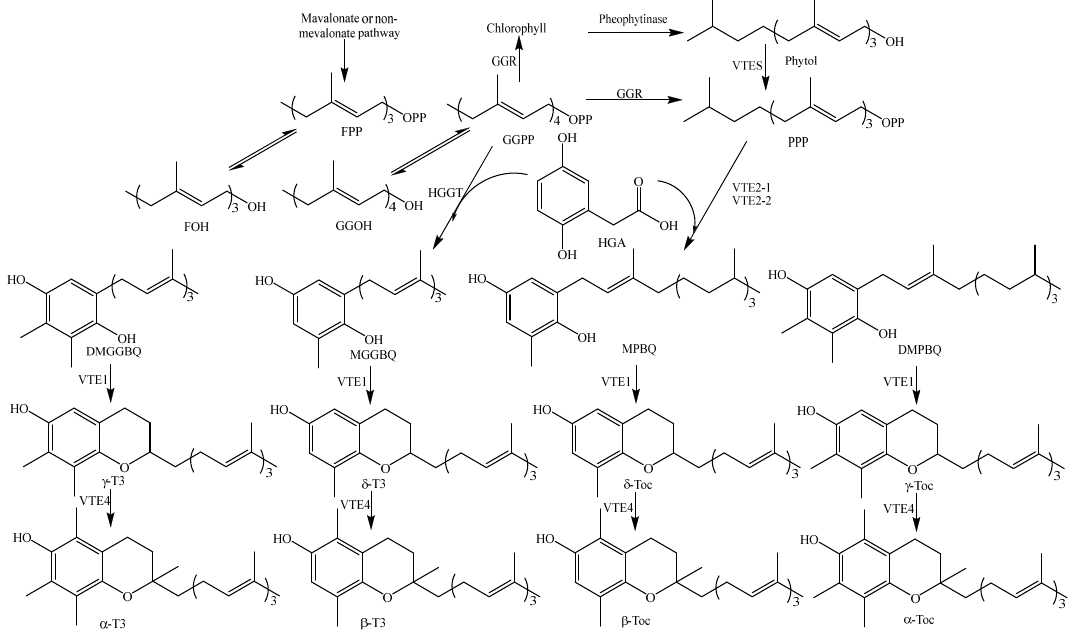
Figure 14. General biosynthetic pathway for vitamin E in plants [146]. Abbreviations: T3, tocotrienol; Toc, tocopherol; FOH, farnesol; GGOH, geranylgeraniol; FPP, farnesyl pyrophosphate; GGPP, geranylgeranyl pyrophosphate; PPP, phytyl pyrophosphate; HGA, homogentisic acid; MGGBQ, 2-methyl-6-geranylgeranylbenzoquinol; DMGGBQ, 2,3-dimethyl-6-geranylgeranylbenzoquinol; MPBQ, 2-methyl-6-phytylbenzoquinol; DMPBQ, 2,3-dimethyl-6-phytylbenzoquinol. The enzymes HGGT, GGR, VTE2-1,2, T3/Toc methyltransferase (VTE3 and VTE4), T3/Toc cyclase (VTE1), pheophytinase, and phytol kinase (VTE5) are believed to be involved in vitamin E